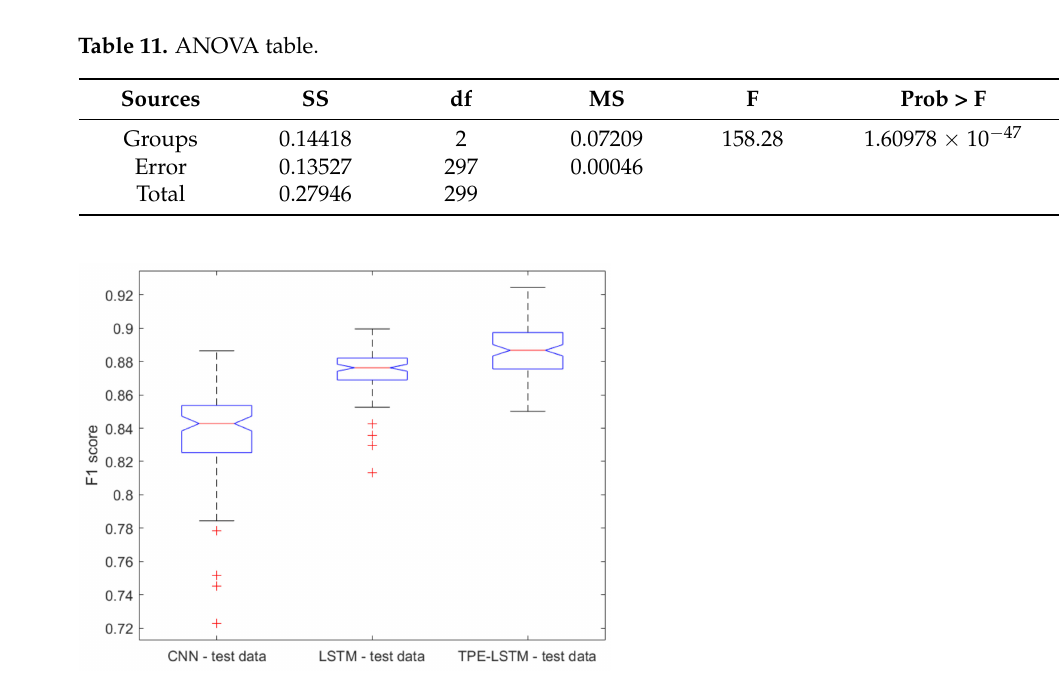
Figure 5. F1 score: test data, all runs. CNN, LSTM, and TPE-LSTM.